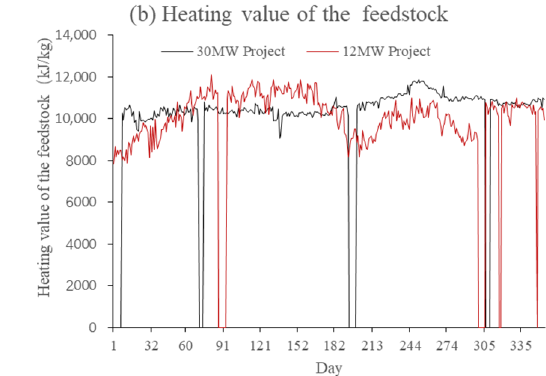
Figure 2. Water content ( a ) and heating value ( b ) of the feedstock.